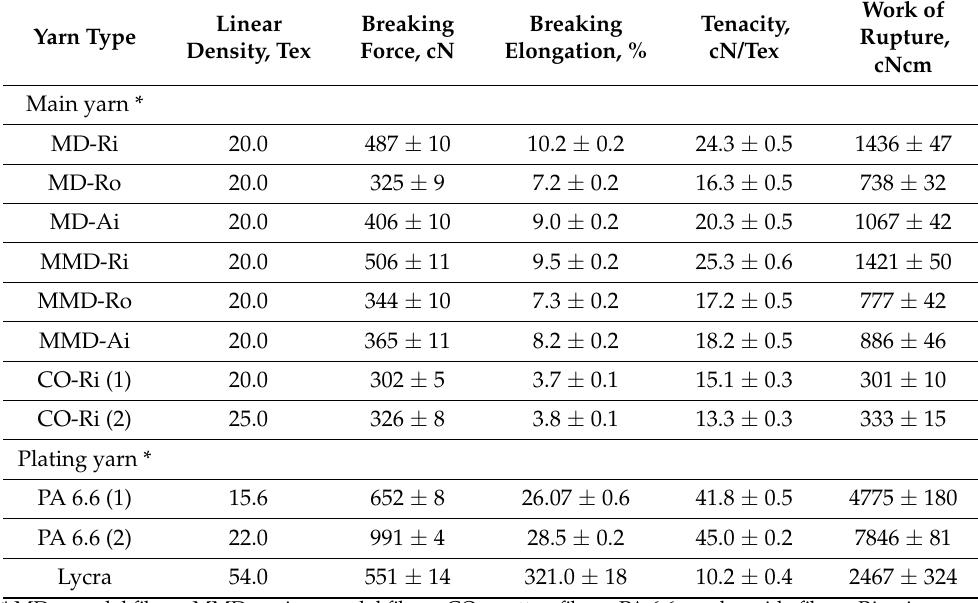
Table 2. Properties of the yarns used in the knitting of socks.